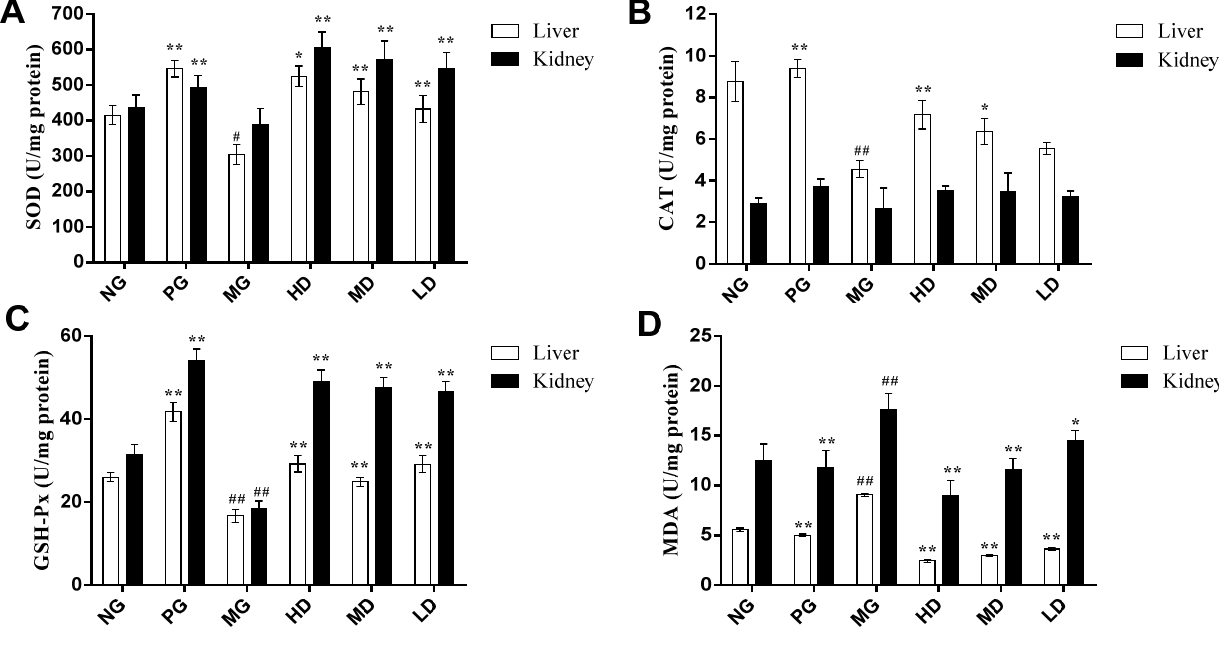
Figure 2. Effect of the phenolic extract on the SOD, CAT, GSH-Px activities and MDA content in the liver and kidney of aging mice induced by D -galactose. ( A ) SOD; ( B ) CAT; ( C ) GSH-Px; and ( D ) MDA. Results are expressed as a mean ± SD (n = 10). # p < 0.05, ## p < 0.01 compared with the normal group (NG). * p < 0.05, ** p < 0.01 compared with the model group (MG). PG: Positive control group; HD: High-dose extract treated group; MD: Middle-dose extract treated group; LD: Low-dose extract treated